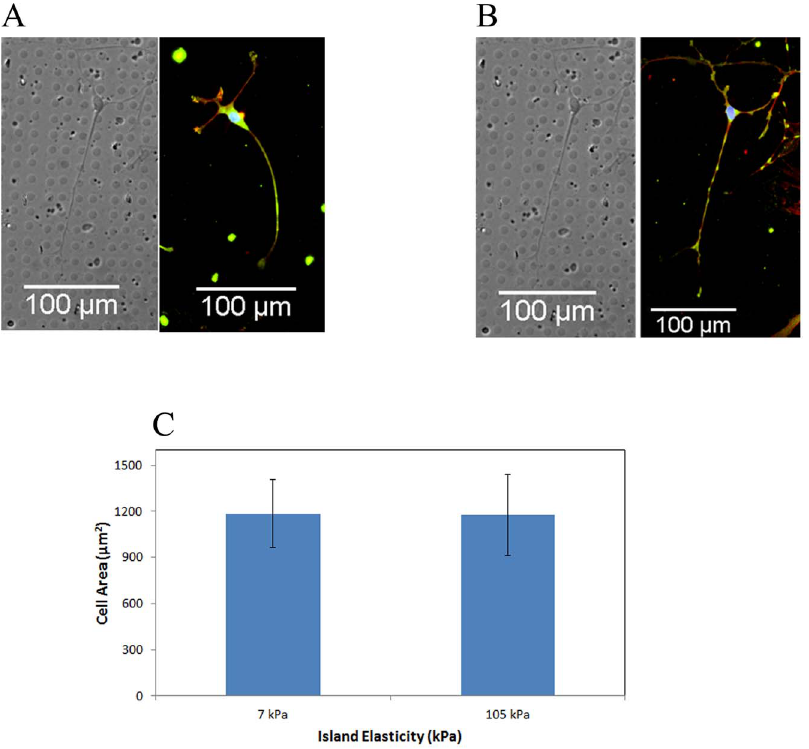
Figure 5. ROCK inhibited cells lose ability to sense matrix conditions. Cells were treated for 7 days, which prevented cells from sensing matrix conditions and spreading as was previously found. (A) ROCK inhibited cell on pattern of 7 kPa PEG, 2.5 MPa background elasticity, 7 m m spacing, and 50 m g ml 2 1 ligand density with brightfield image and vinculin, F-actin, and nucleus staining merged image. Average cell area for this ROCK inhibited trial was 1184.37 m m 2 6 223.84 m m 2 . (B) ROCK inhibited cell on pattern of 105 kPa PEG, 2.5 MPa background elasticity, 7 m m spacing, and 50 m g ml 2 1 ligand density with brightfield image and vinculin, F-actin, and nucleus staining merged image. Average cell area for this ROCK inhibited trial was 1175.46 m m 2 6 265.79 m m 2 . Error bars are standard error of over 10 cells quantified per condition. doi:10.1371/journal.pone.0081113.g005 Figure 5A and Figure 5B. 7 kPa island elasticity cell area averages were 1184.37 6 223.84 m m 2 while 105 kPa island cell areas were 1175.46 m m 2 6 265.79 m m 2 . Integrins and focal adhesions are the